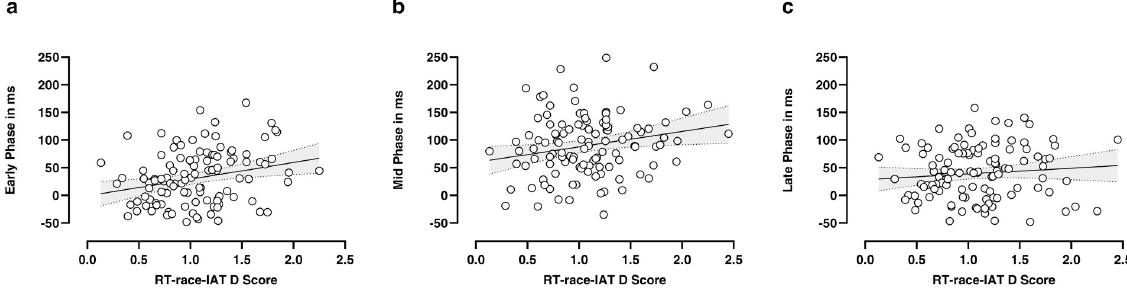
Fig 6. Linear regressions between RT-race-IAT D Score vs Early ( a ), Mid ( b ) and Late ( c ) conflict’s temporal unfolding phases. The solid line indicates the best linear model, and the dashed lines indicate the 95% confidence intervals.